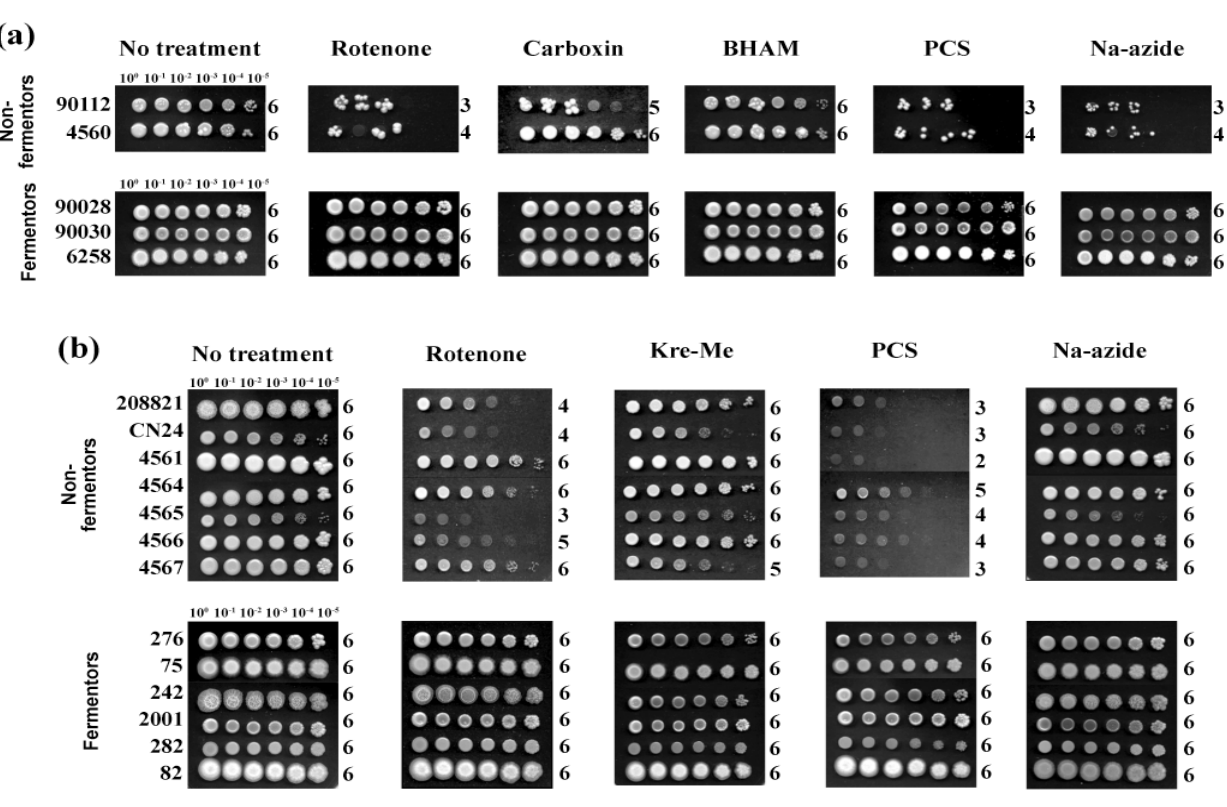
Figure 2. Differential antifungal activity of MRC inhibitors, targeting complexes I - IV or AOX, in yeast pathogens. ( a ) Representative yeast dilution bioassay showing Cryptococcus strains, non-fermentors, are relatively more sensitive to MRC inhibitors (rotenone, carboxin, PCS, Na-azide) than Candida strains, fermentors. 10 0 to 10 − 5 , yeast-cell score of cell numbers dilution level; Numbers on the right side of each row (0 to 6), log 10 visible (survived) (See Experimental section and Table 3). ( b ) Yeast dilution bioassay showing PCS is the most potent MRC inhibitor tested, followed by rotenone (Cell dilution level showing visible growth equates to antifungal potency [higher dilution score with visible growth = lower potency]; PCS, average log score = 3.4 ± 0.9 vs. rotenone, average 10 log score = 4.6 ± 1.2. Average log score was determined in nine Cryptococcus strains). 10 10 As observed in panel (a), Candida strains did not exhibit growth inhibition to any of